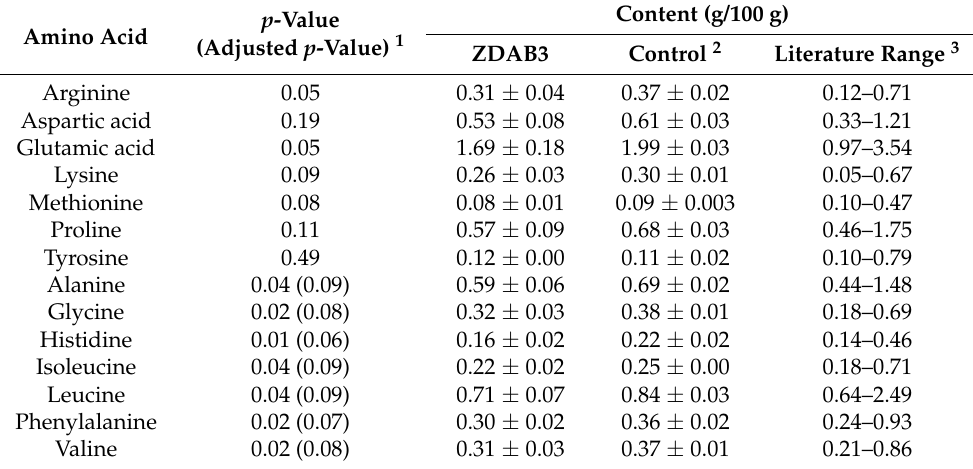
Table 5. Amino acid values in maize samples.